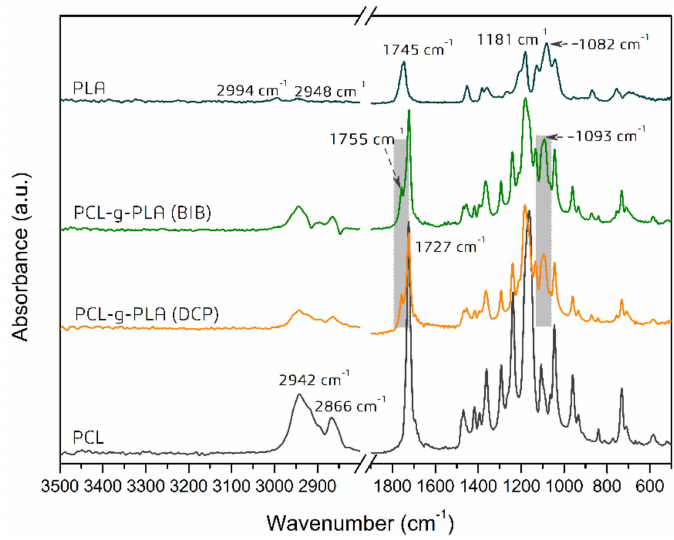
Figure 1. FTIR absorption spectra of neat PCL and PLA, and PCL- g -PLA copolymers.